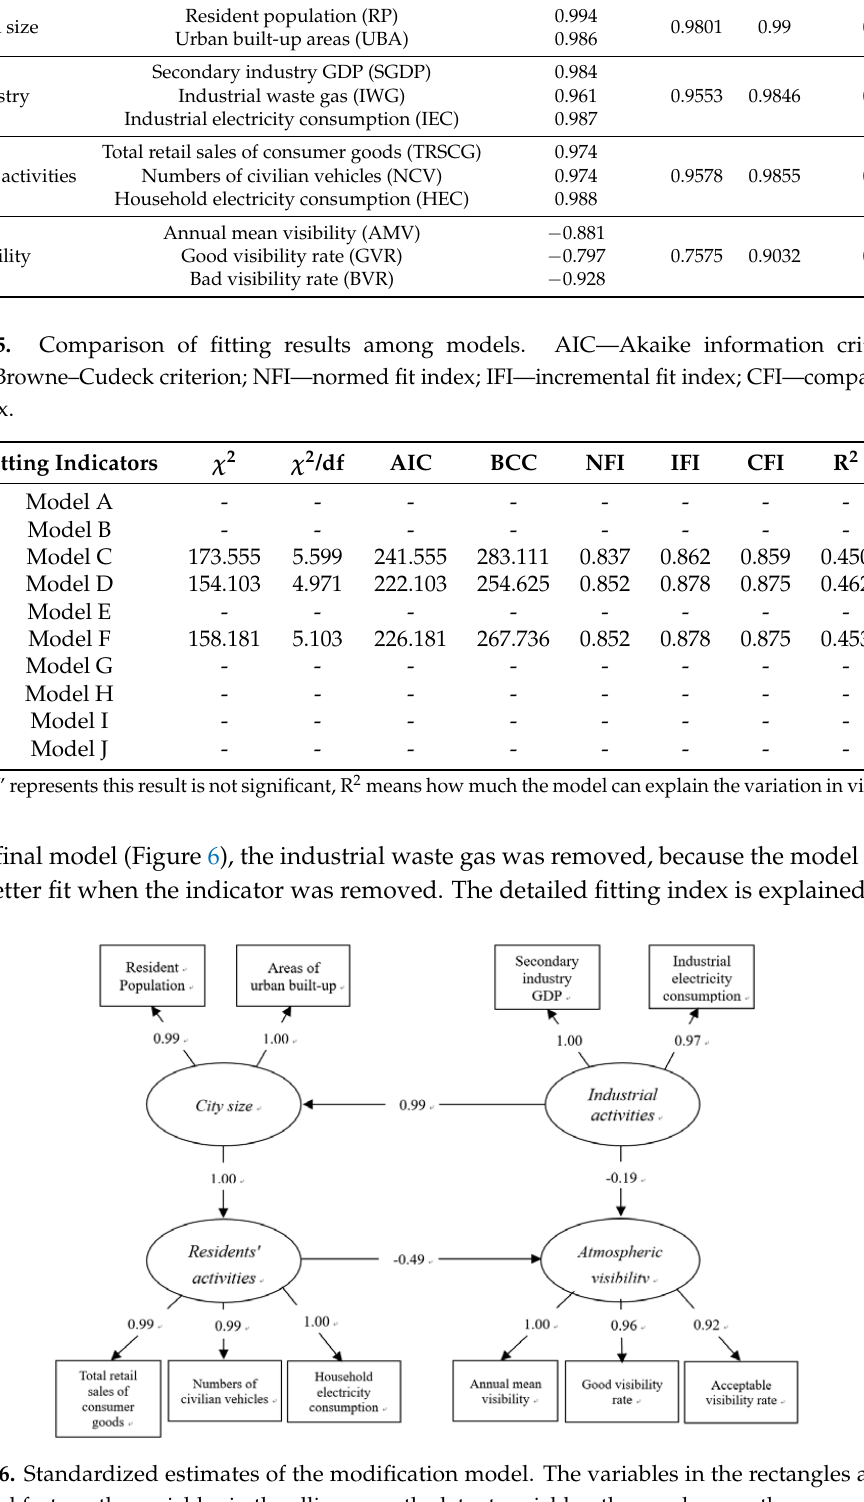
Table 4. Test of measurement scale. CR—composite reliability; AVE—average variance extracted.